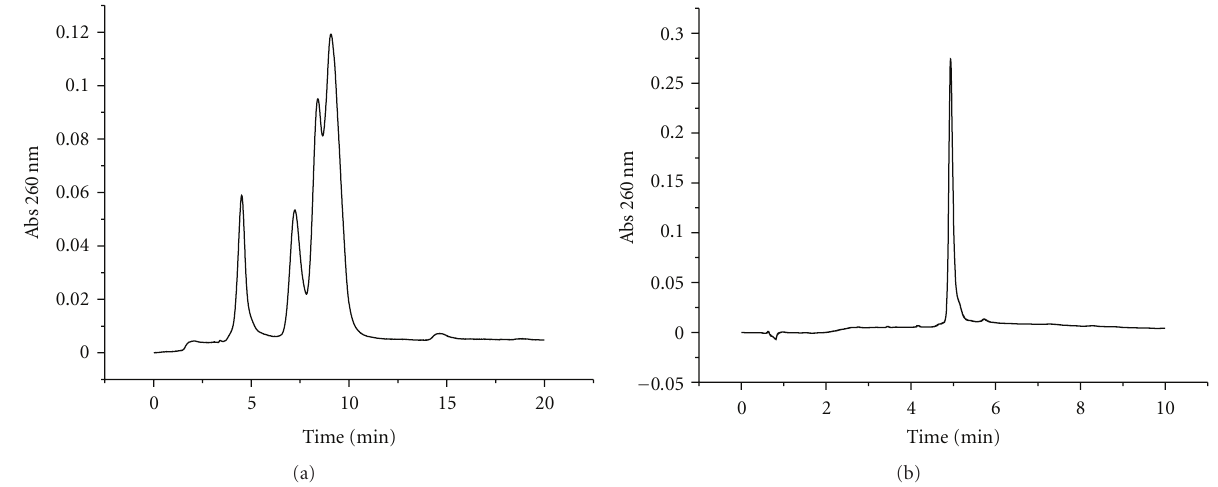
Figure 5: HPLC purification of oligonucleotide 3 with four arms. (a) HPLC profile of DMT-containing oligonucleotide 3 . The last fraction contained the desired sequence with four DMT groups; (b) analytical HPLC of purified oligonucleotide 3 after removal of DMT groups.